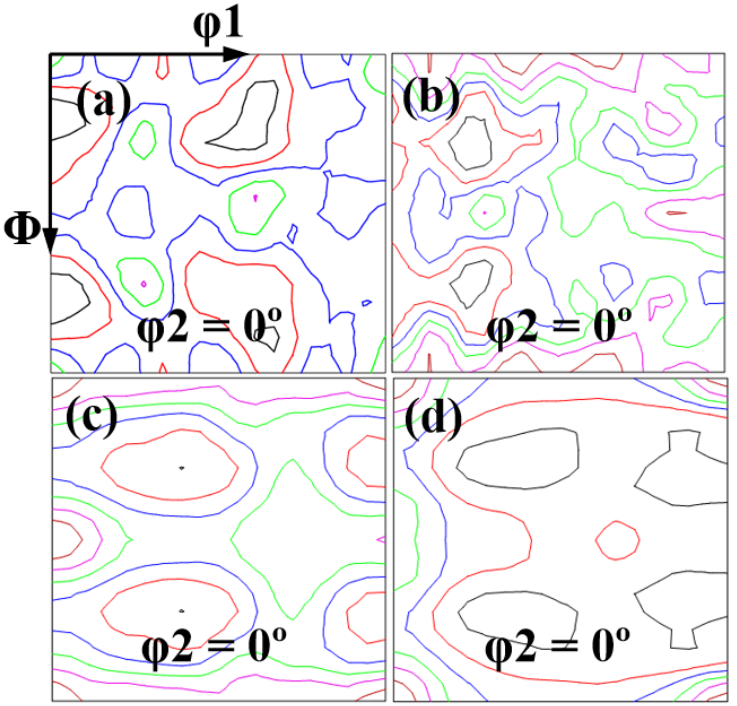
Figure 10. Sections ( ϕ = 0 ◦ ) of ODFs on the rolling plane of sample after different rolling deformations and annealing treatments at 470 ◦ C for 0.5 h: ( a ) 10%; ( b ) 40%; ( c ) 60%; ( d ) 80%.